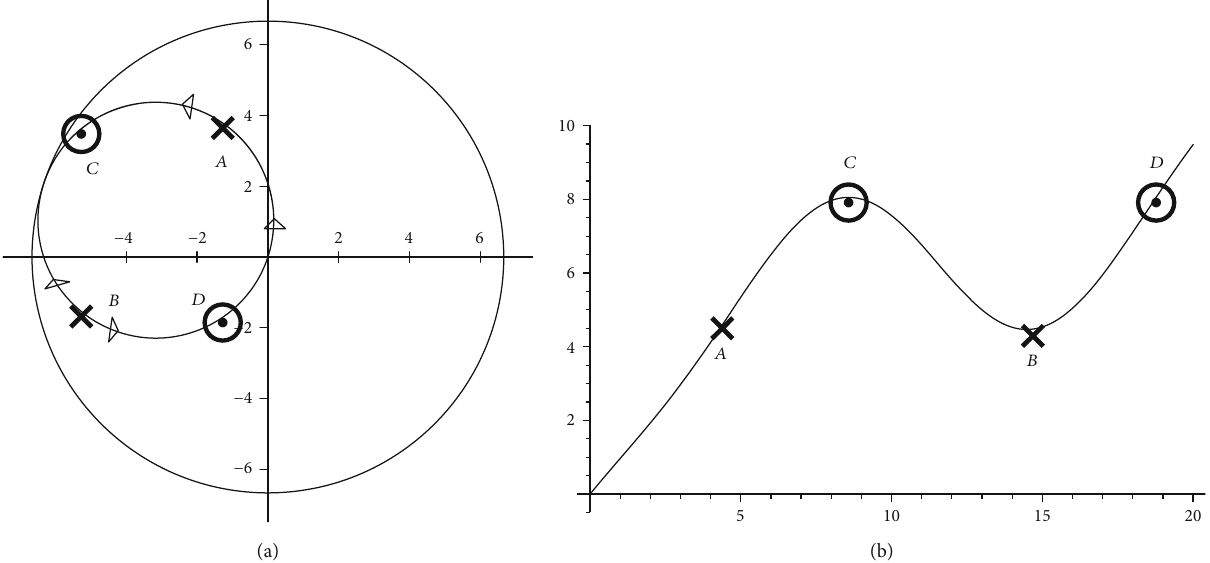
= 0 : 95 , and initial p = 0 where the light positive for p y x z